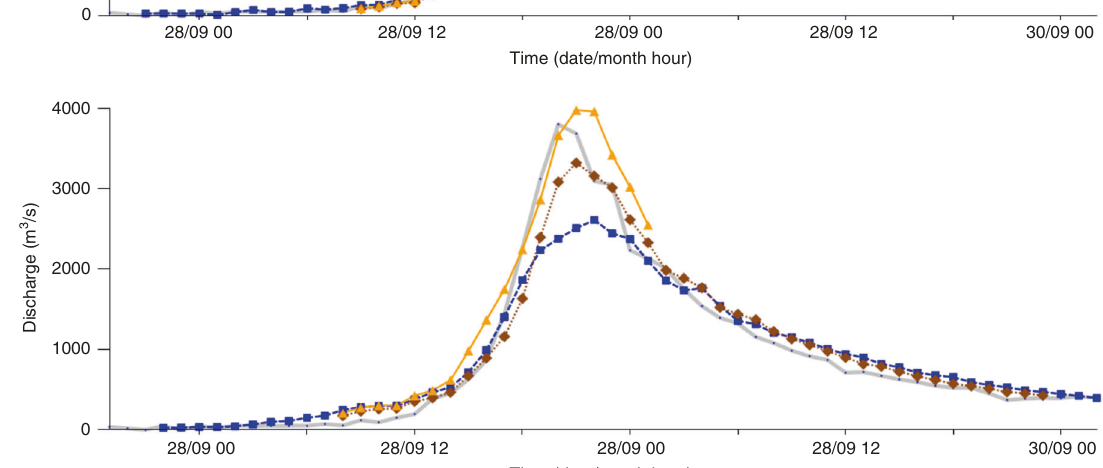
Fig. 9 Predicted fl ood hydrographs for Typhoon Dujuan. Predictions were made using two fl ow characteristic curve selection strategies under three typhoon duration schemes. a Actual typhoon tracks grouped in cluster #3. This is the best matched cluster while Typhoon Talim is the best matched track. b Predicted fl ood hydrographs using the fi rst selection strategy. c Predicted fl ood hydrographs using the second selection